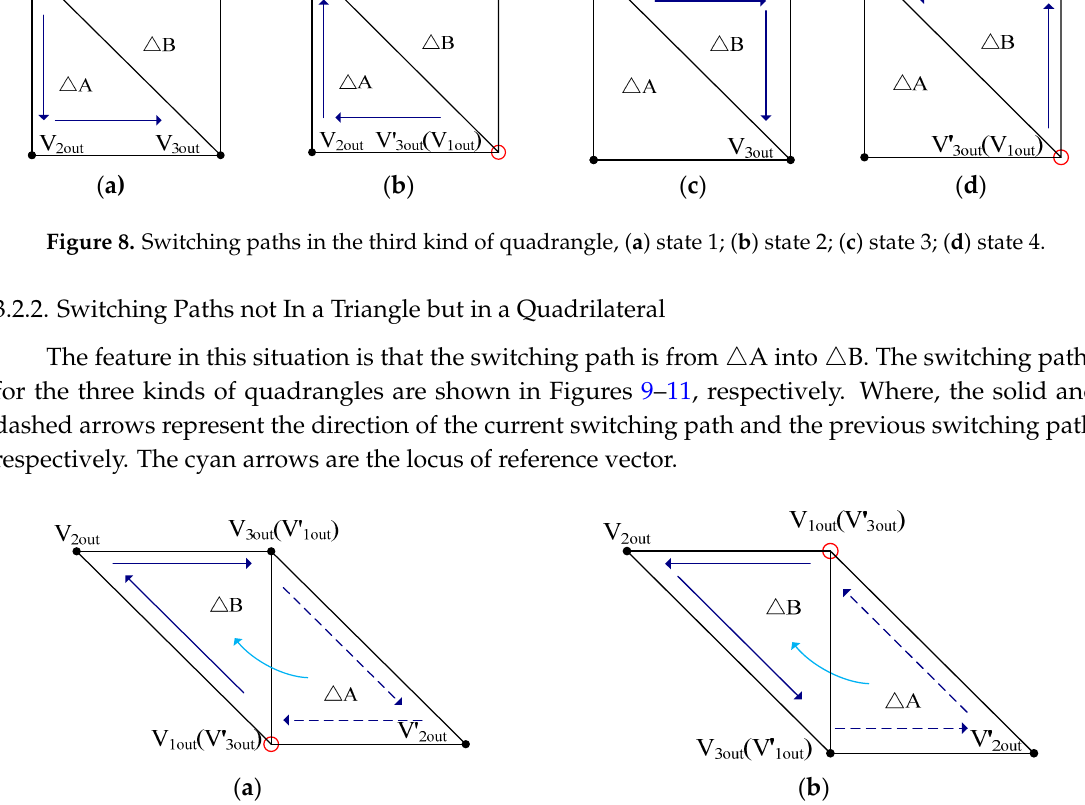
Figure 9. Switching paths in the first kind of quadrangle, ( a ) state 1; ( b ) state 2.